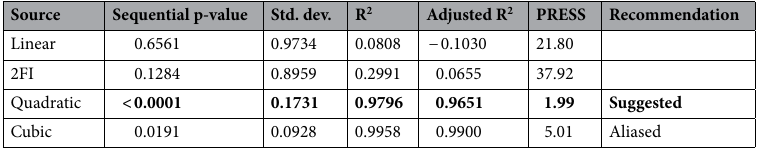
Table 12. Model summary statistics of voids zone for hot-rolled steel. Significant values are in bold.